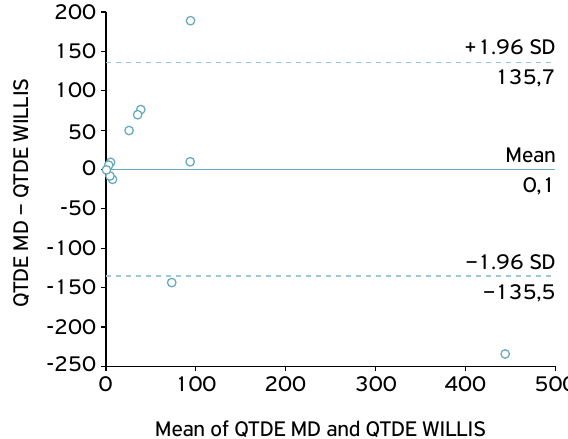
Figure 2. Joint comparison of all positive evaluations between direct (MD) and Willis.